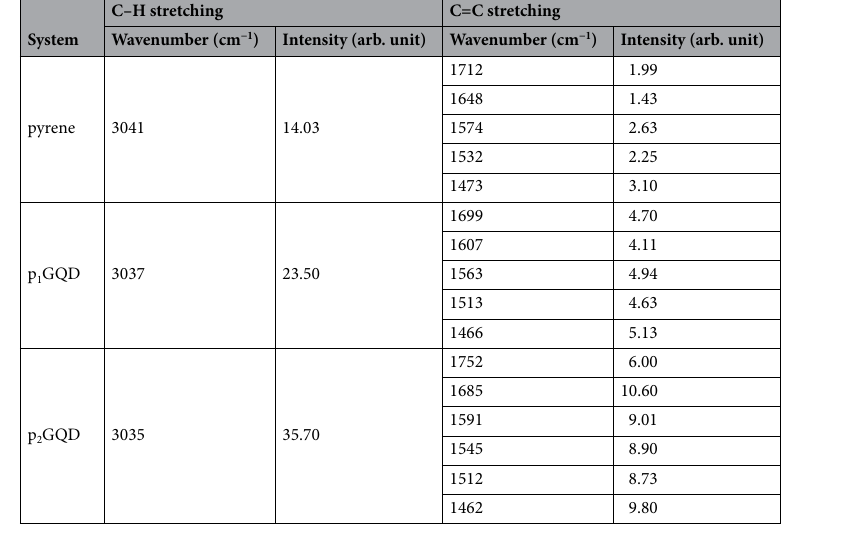
Table 2. The vibration mode of Pyrene, p1GQD, and p2GQD.